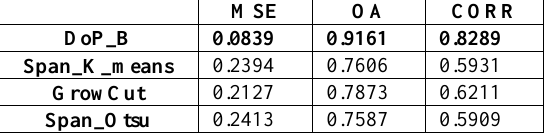
Figure 3. Extracted edges by Canny operator: (a) Ground truth, (b) Otsu, (c) K-means, (d) GrowCut, (e) Proposed Table 1 Segmentation results of UAVSAR oil spill